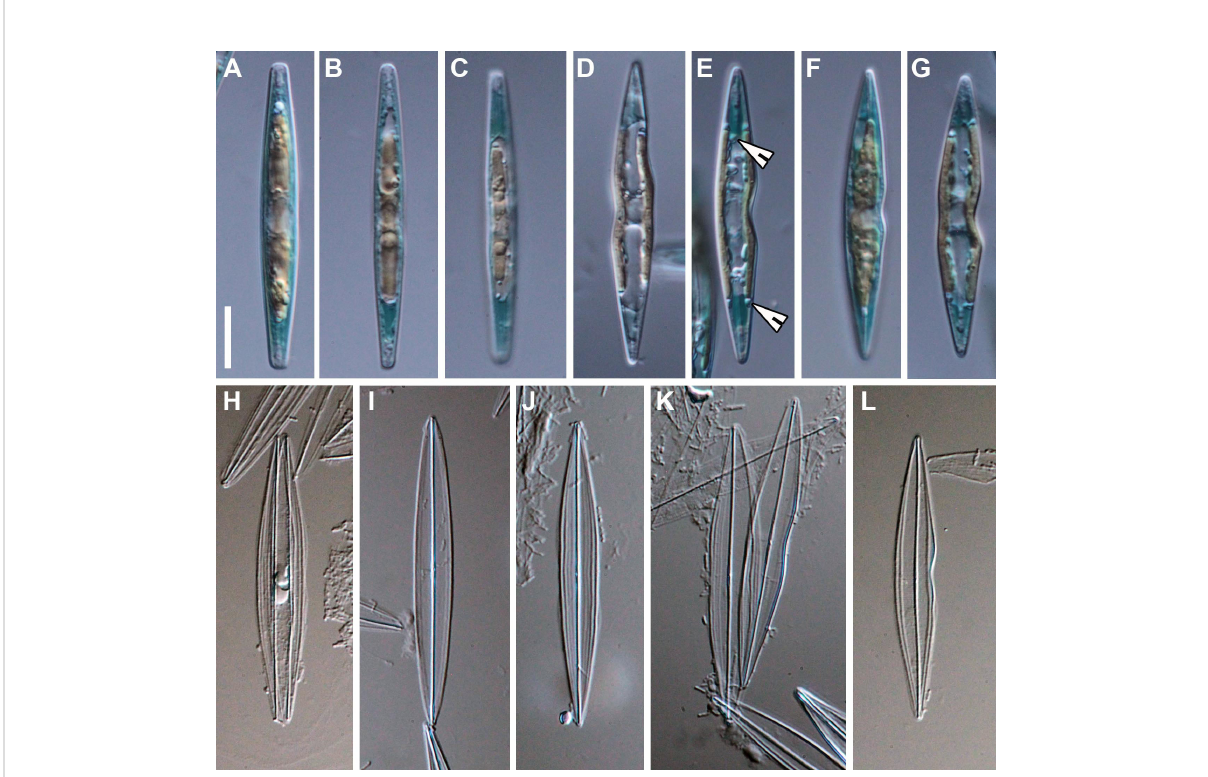
FIGURE 1 Haslea ostrearia SZCZP1883. (A – G) Live diatoms. Note the chloroplast arrangement and intracellular marennine (IMn) accumulation at the tips of the cells. Note the pyrenoids on 1E (arrowheads). (H – L) Light microscopic images of the cleaned material. Scale bar = 10 m